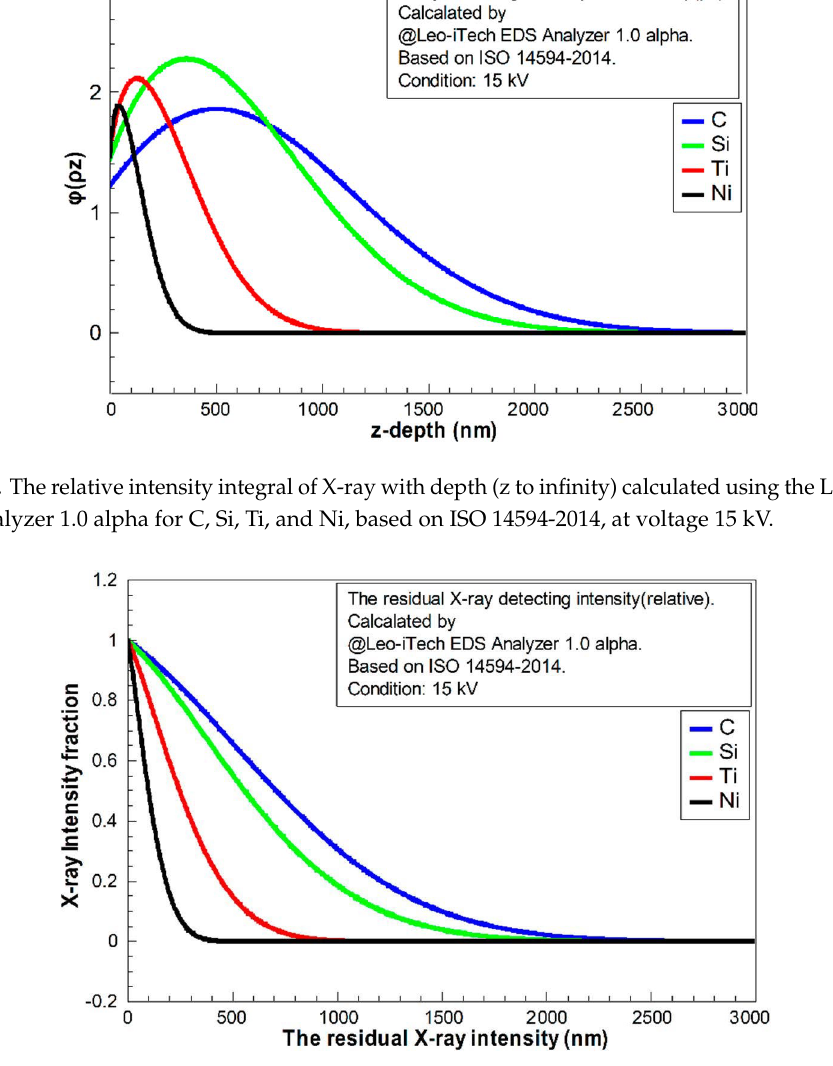
Figure 5. The relative intensity integral of X-ray with depth (z to infinity) calculated using the Leo-iTech EDS Analyzer 1.0 alpha for C, Si, Ti, and Ni, based on ISO 14594-2014, at voltage 15 kV.